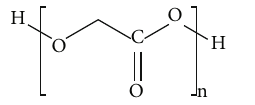
Figure 40: PGA chemical